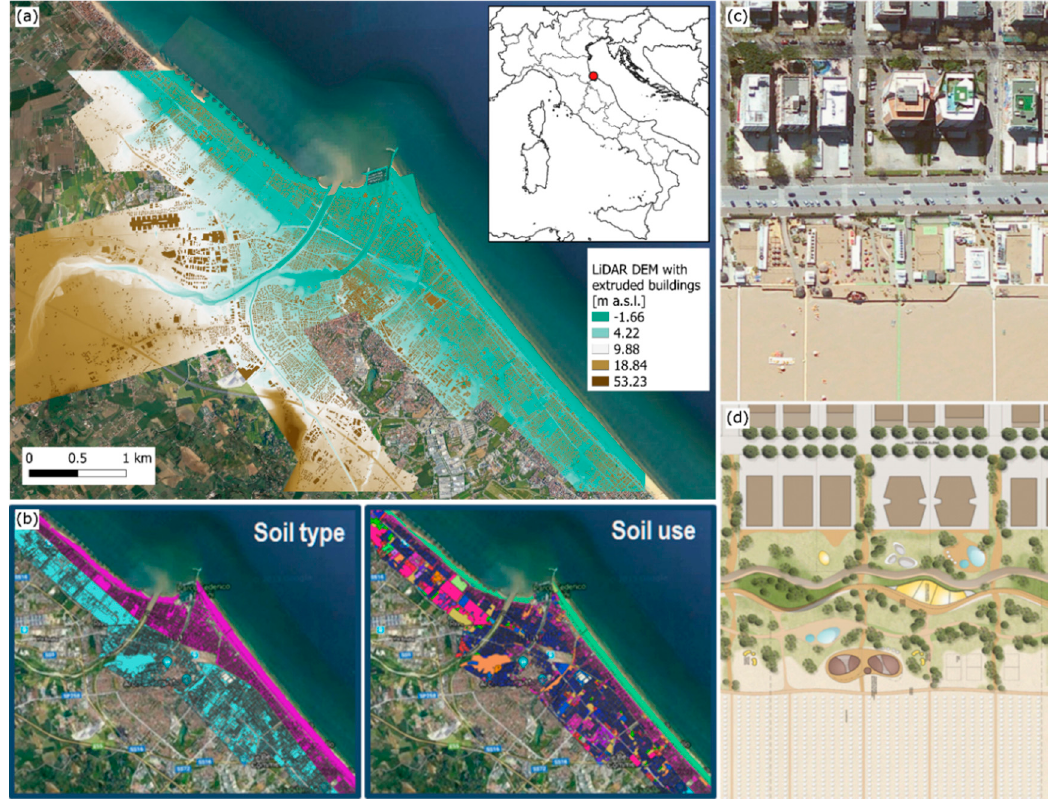
Figure 7. Geographic and topographic setting of Rimini, Northern Italy: ( a ) location of the case study and 1 m LiDAR Digital Elevation Model (DEM) with extruded buildings; ( b ) soil-type and land-use maps for the study area; ( c , d ) current layout of the seafront (satellite image) and future green infrastructure according to the rehabilitation and renovation project Parco del Mare .